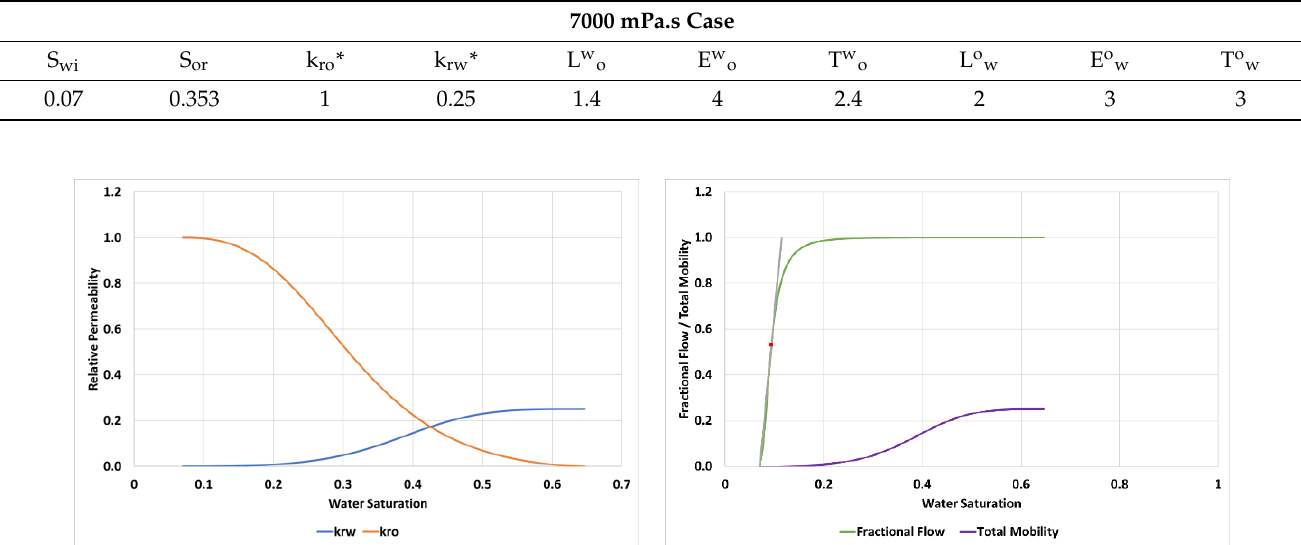
Figure 10. Relative permeabilities ( left ) and fractional flow & total mobility ( right ) for the displace- ment of 7000 mPa.s oil.